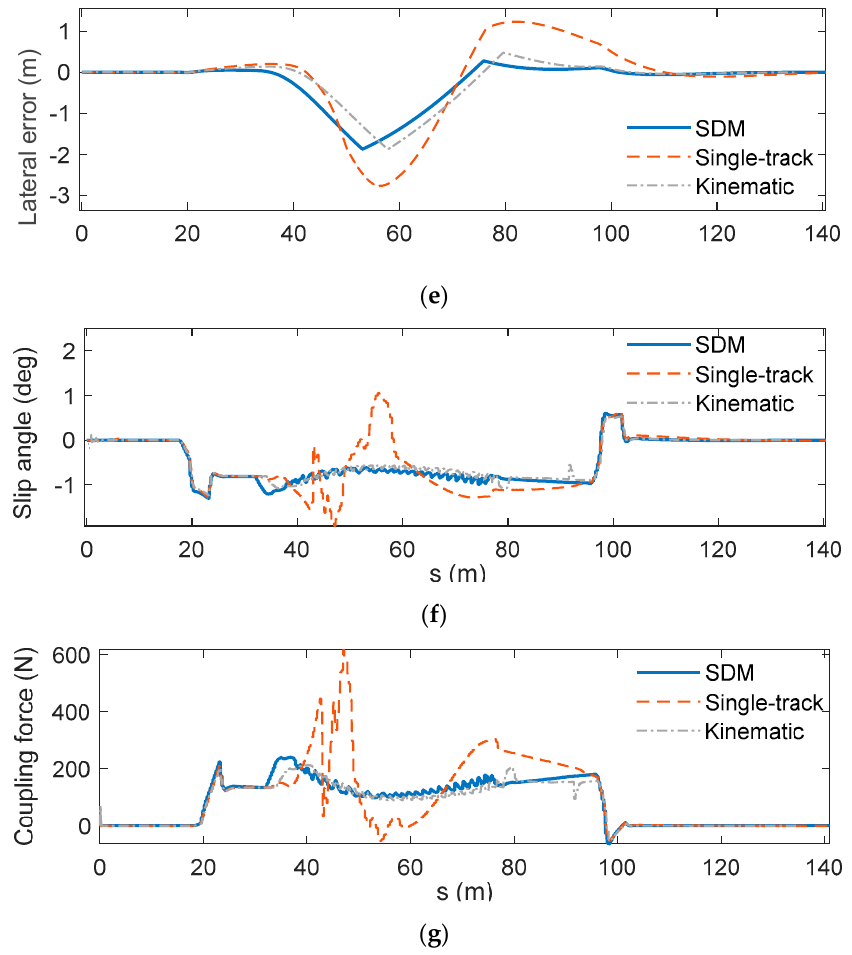
Figure 10. Results of SCENARIO 2. ( a ) Vehicle trajectories. ( b ) Longitudinal driving force. ( c ) Steering angle of front tire. ( d ) Longitudinal speed. ( e ) Lateral error. ( f ) Slip angle of front tire. ( g ) Longitudinal coupling components.